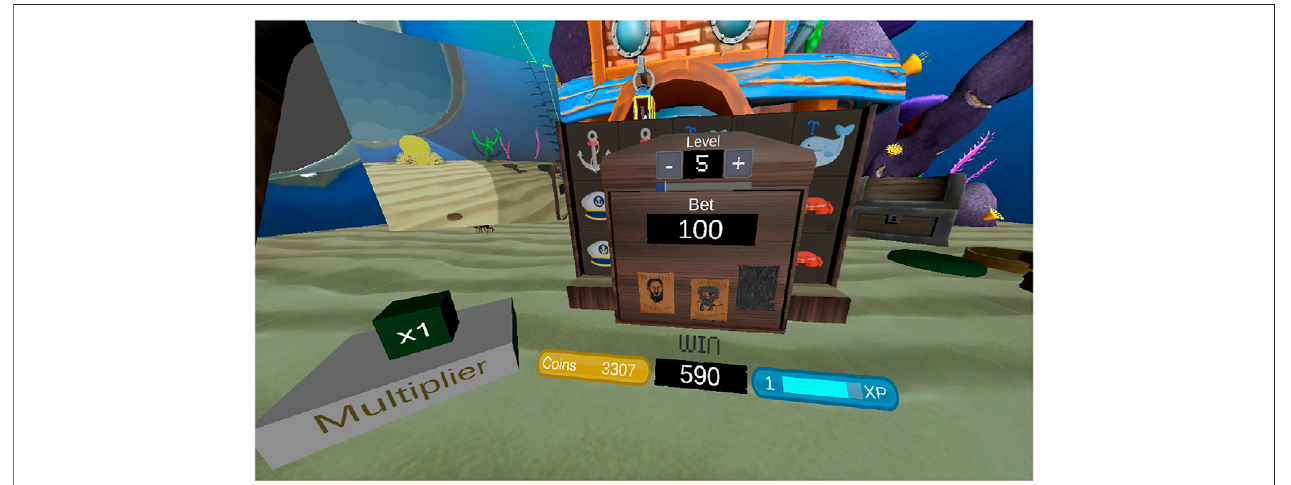
FIGURE2| PlayersofSlotMachineVBcanadjustthebetlevelusingtheVivecontrollers.Underneaththebetmenu,thegamedisplaysaplayer ’ sbalance,win,level, andexperience.Onthelowerleftposition,agreenboxindicatesthemultiplier.Playerscanwatchthemselvesgamblinginthevirtualmirrorpositionedtotheleftoftheslot machine